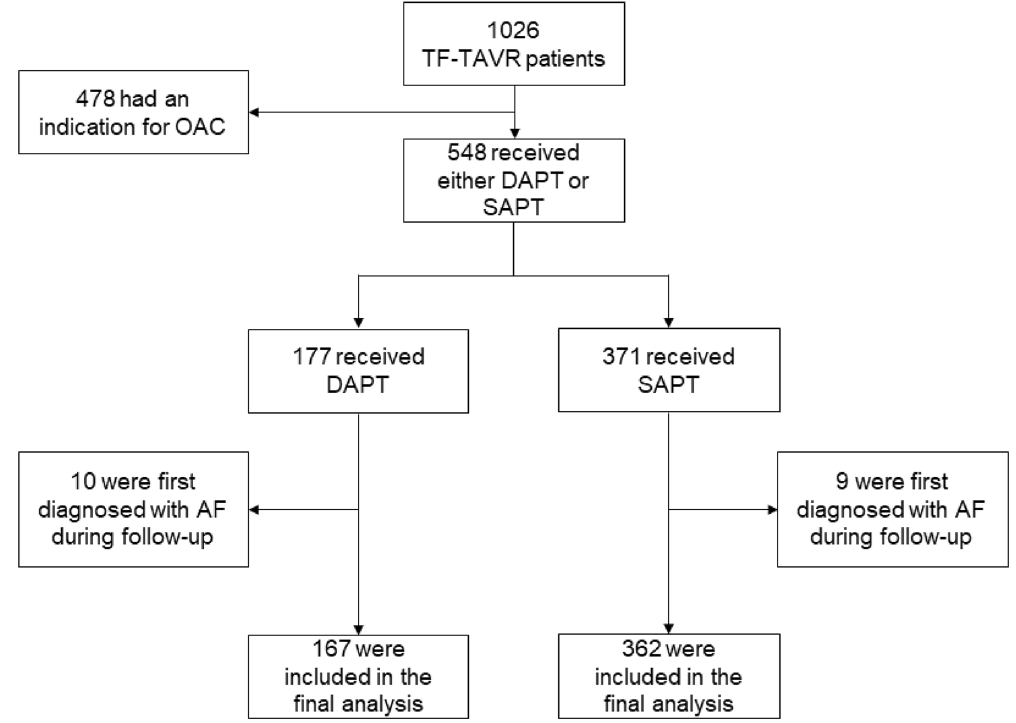
Figure 1. Study design. A total of 1026 patients undergoing transfemoral TAVR had been prospectively enrolled. During follow-up, 19 patients were excluded due to the diagnosis of atrial fibrillation. Finally, the DAPT group comprised 167 patients and the SAPT group 362